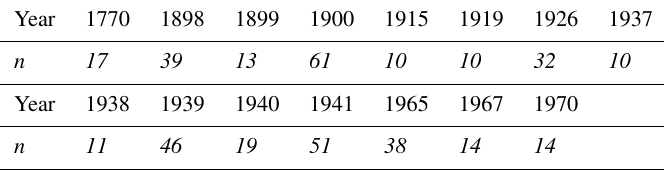
Table 4. The most important 15 landslide years (1770–1989) when at least 10 records were